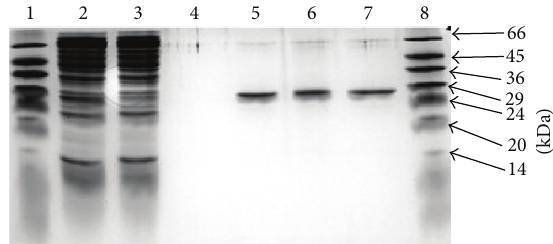
Figure 2: Electrophoretic analysis of the different fractions of AgGST 𝜀 2. Lane 1 contained molecular weight markers. Lane 2 contained the supernatant fraction obtained after lysis, sonication, and centrifugation of E. coli cells. Lane 3 contained the nonbound fraction containing protein that did not bind the affinity chro- matographic ligands hexyl GSH/GSH. Lane 4 contained the wash fraction. Lane 5 contains the affinity pool fraction. The concentrate fraction is contained in lane 6 whilst lane 7 contained the dialysate fraction. Lanes 2 and 3 contained numerous bands indicating the presence of unwanted proteins. The single bands shown in lanes 5, 6, and 7 indicate that GST 𝜀 2 was purified to